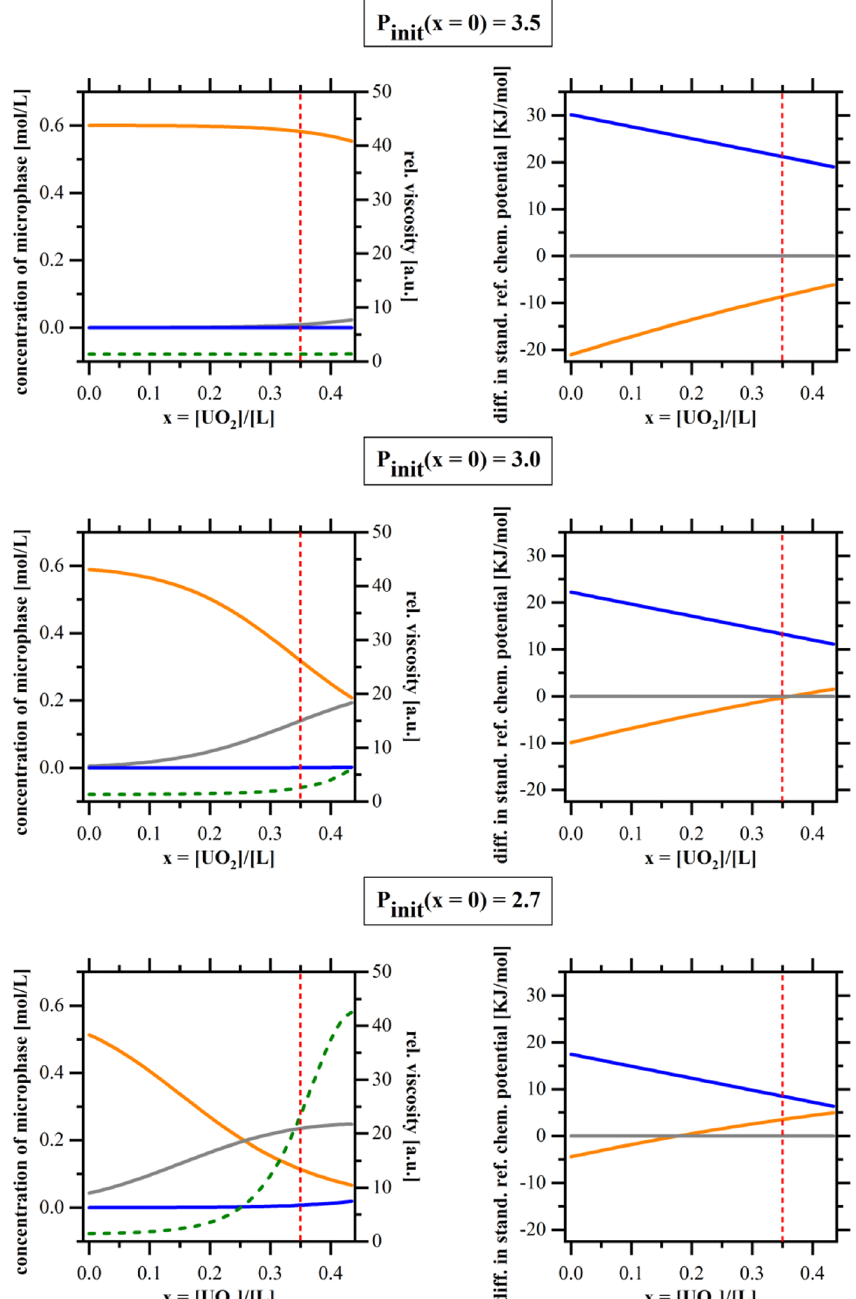
Fig. 14. Calculated microphase distribution of endcaps (orange), cylinders (grey) and junctions (blue) as well as the corresponding differences in standard reference chemical potential respective to cylinders dependent on the initial spontaneous packing parameter P init and the uranyl content x . The calculated relative viscosity curve is shown in as dashed green line. The relative decrease of the initial spontaneous packing parameter from x = 0 to x = 0.45 was set to D P 0 = 0.7. The total extraction concentration was chosen to be 1.2M and the bending constant k *= 2 kT/extractant. The position of the Monte-Carlo-like simulation shown in Figure 15 is indicated by a red dashed